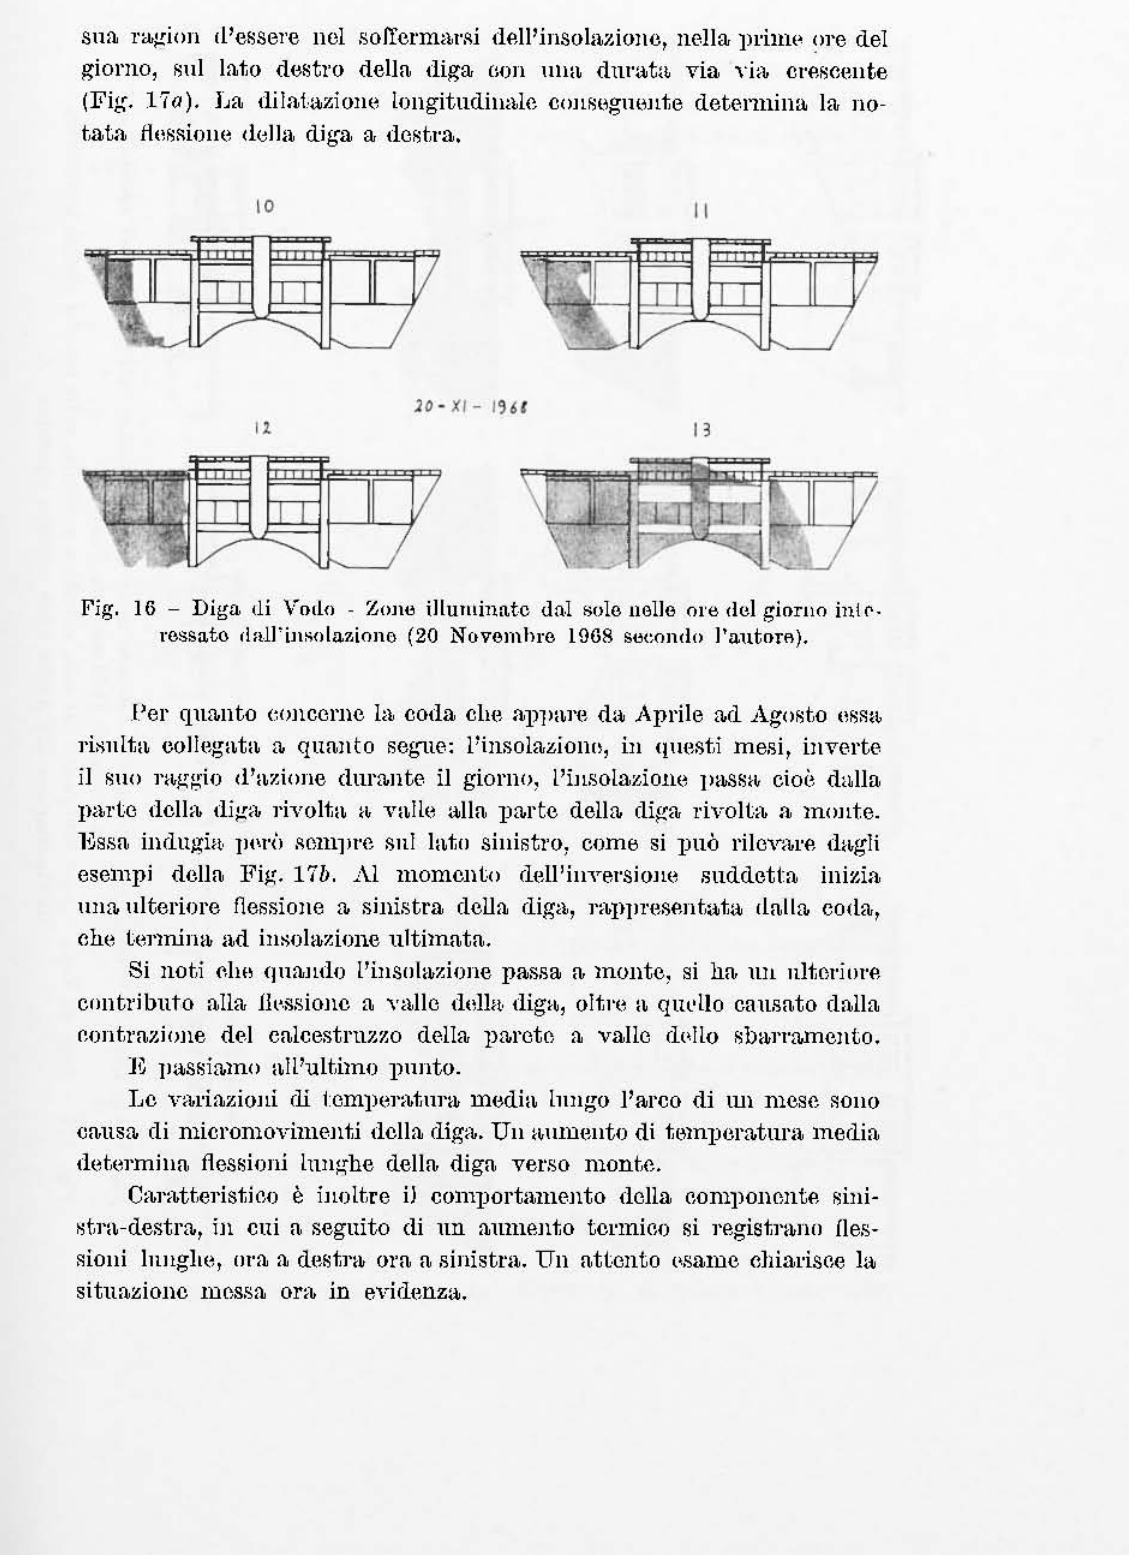
Fig. 16 - Diga. (li V0I1o ZOlle illuminate dal sole nelle me del giorJlo in!r.